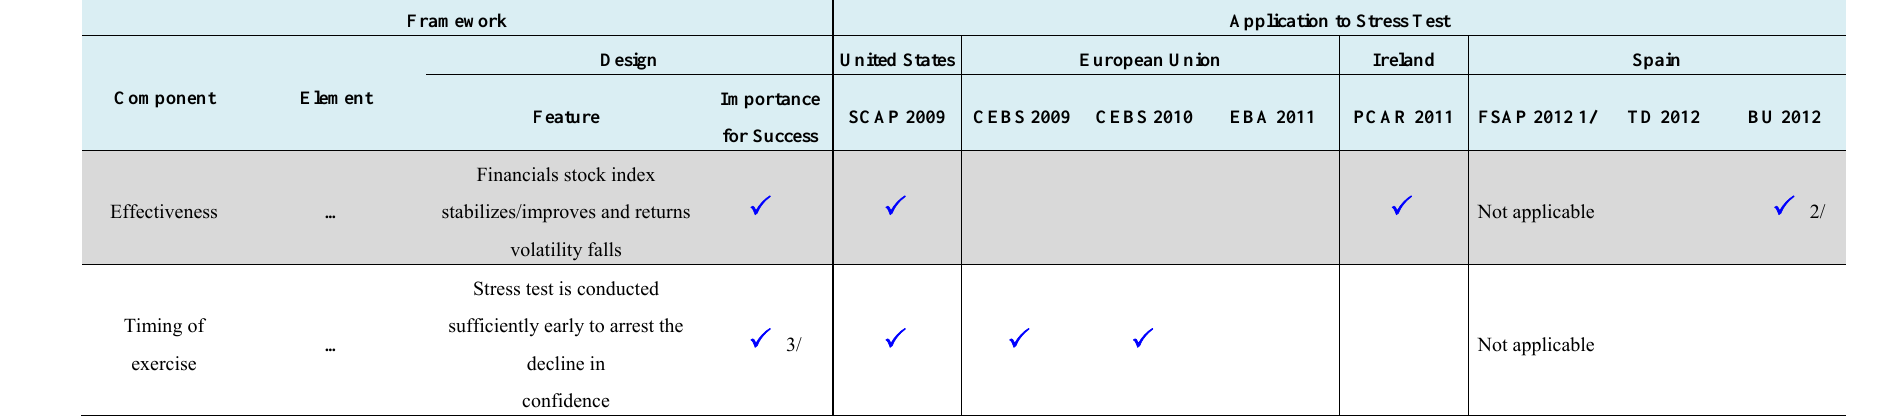
Table 5. Crisis Stress Tests: Design